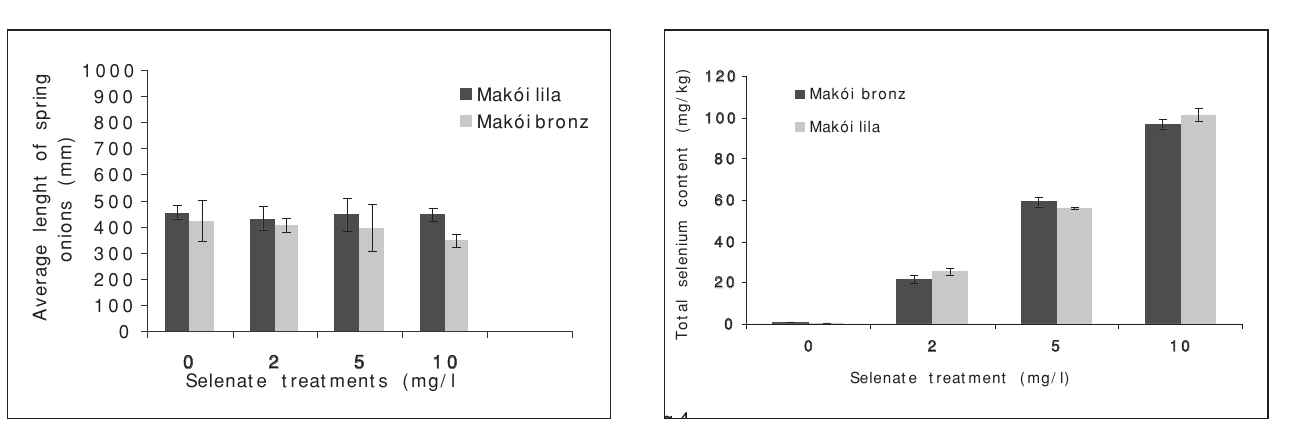
Fig 4: Total selenium content of Makói bronz and Makói lila spring onions depending on selenate treatments (p<0,05)